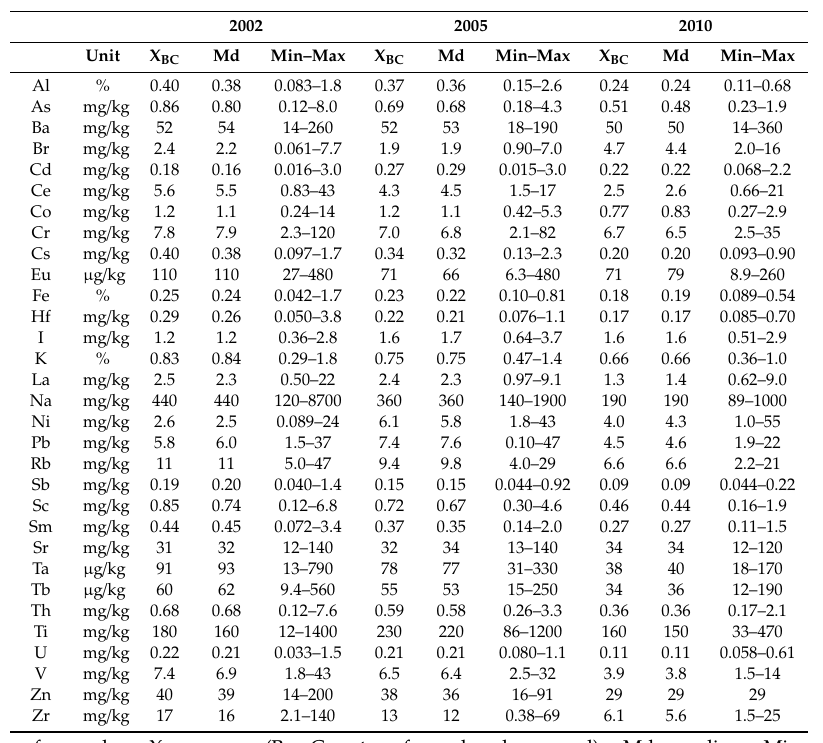
Table 1. Descriptive statistics of measurement according to sampling campaign; n = 72.